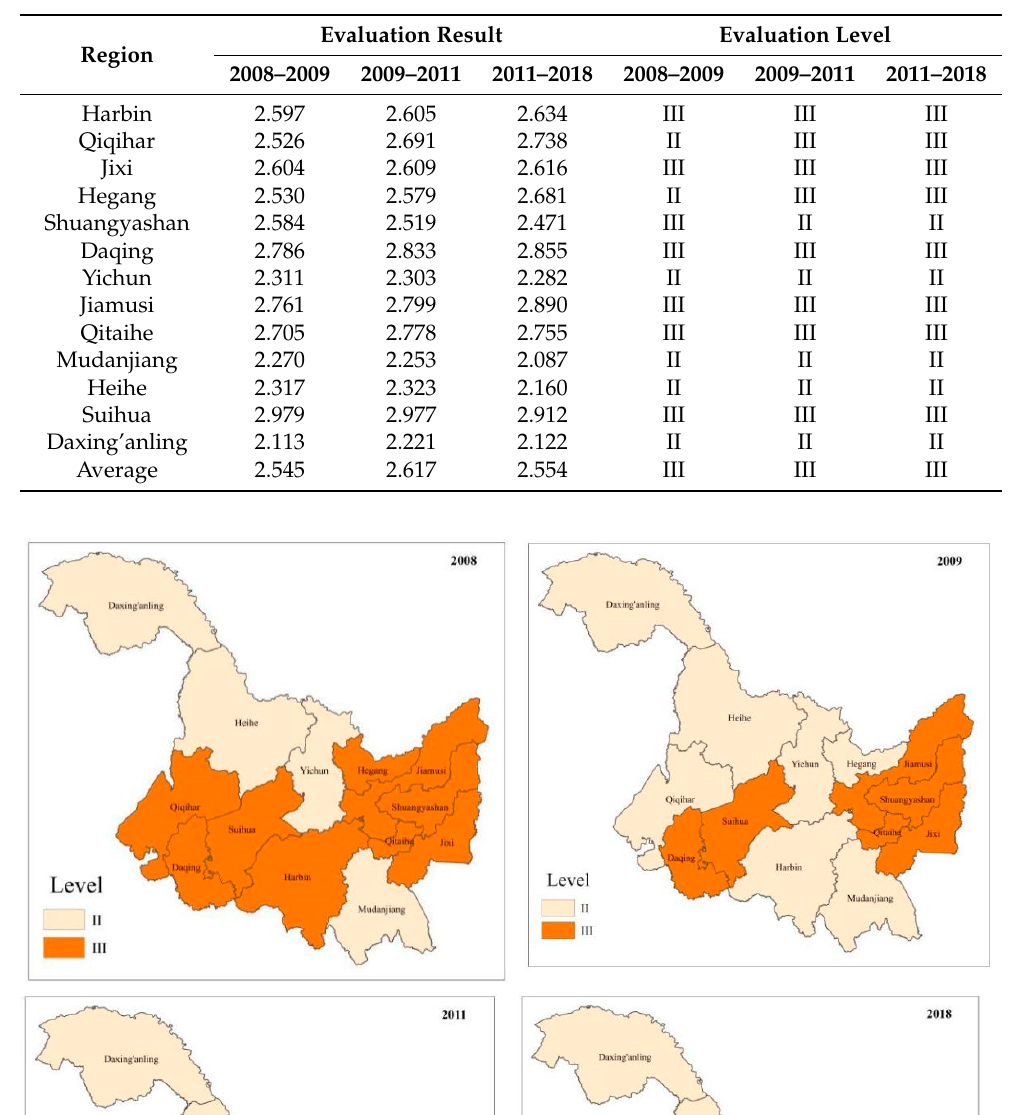
Table 4. Evaluation results and levels of AWLRSV.